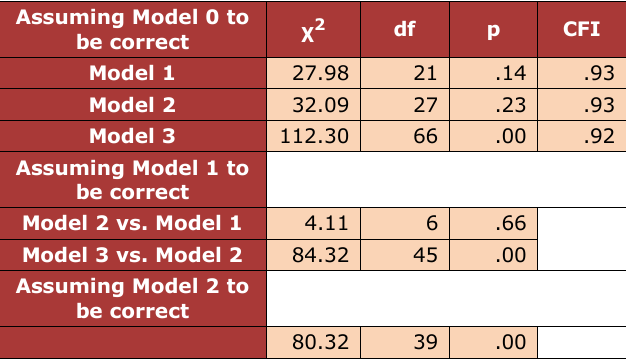
Table 3. CFAs for the cross-validation of the HRM SQ model, using an analysis of factorial